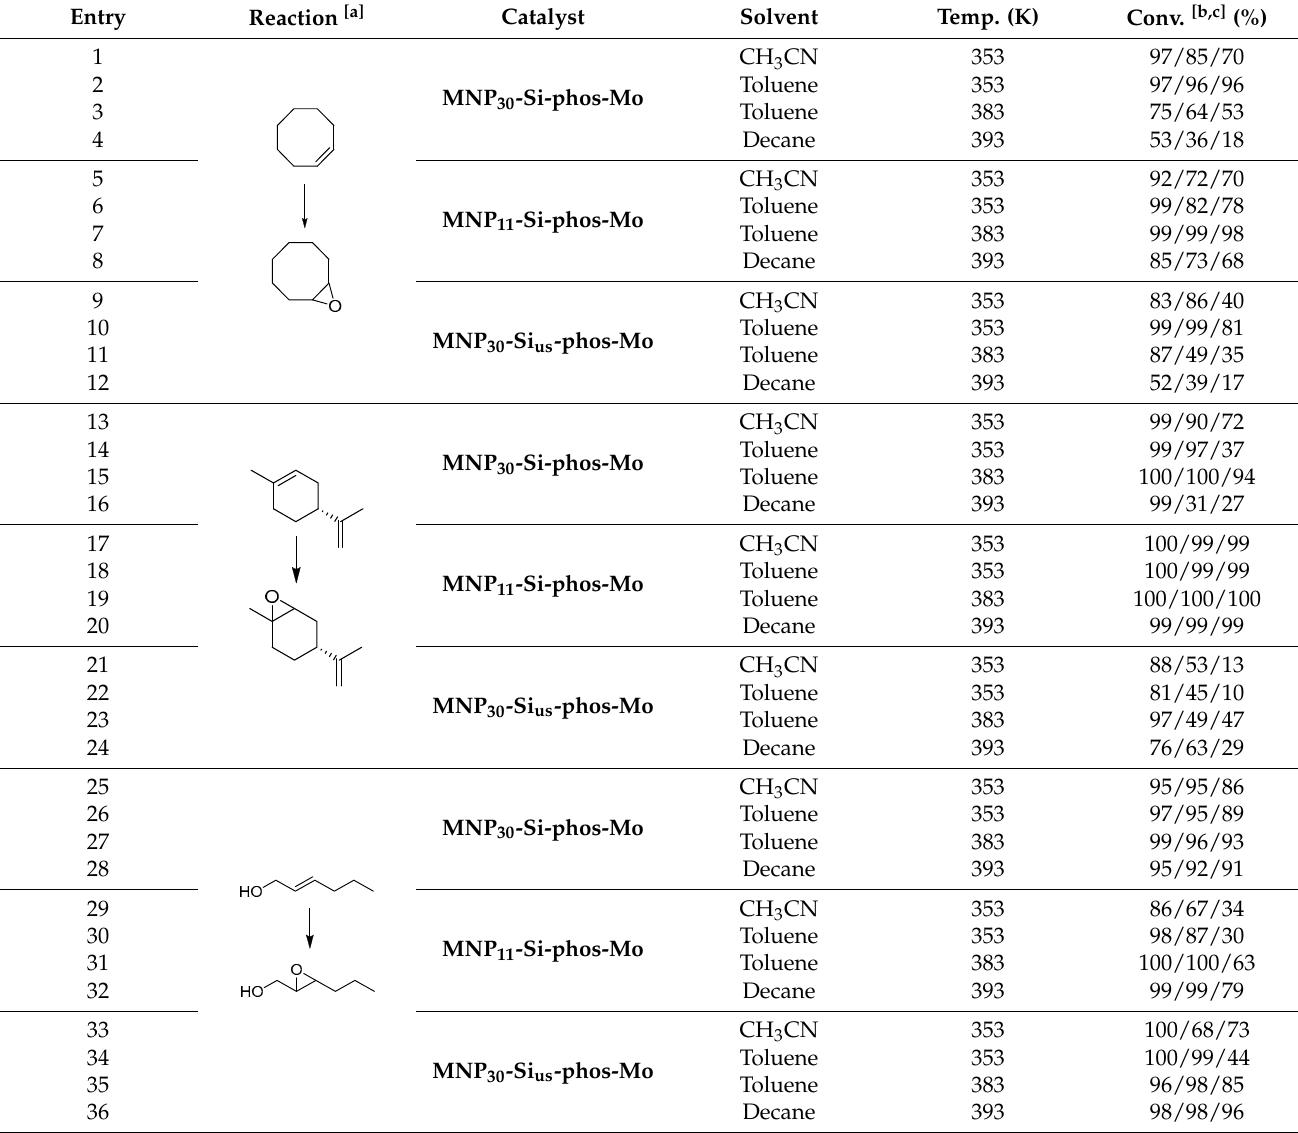
Table 3. Reusability of catalysts MNP 30 -Si-phos-Mo , MNP 11 -Si-phos-Mo, and MNP 30 -Si us -phos-Mo in different reaction conditions.